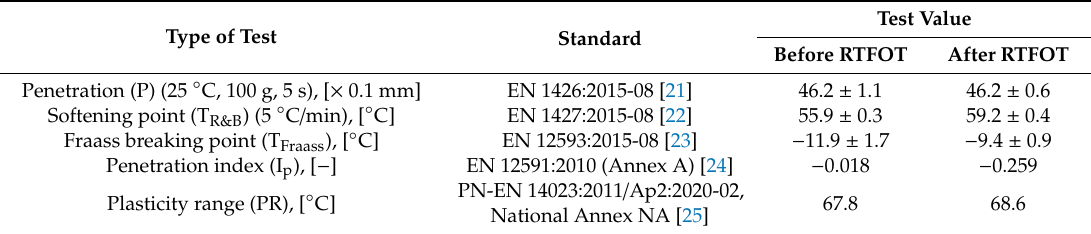
Table 1. The values of the main parameters applied for classification of 35/50 bitumen before and after Rolling Thin Film Oven Test (RTFOT as per EN 12607-1 [20]).